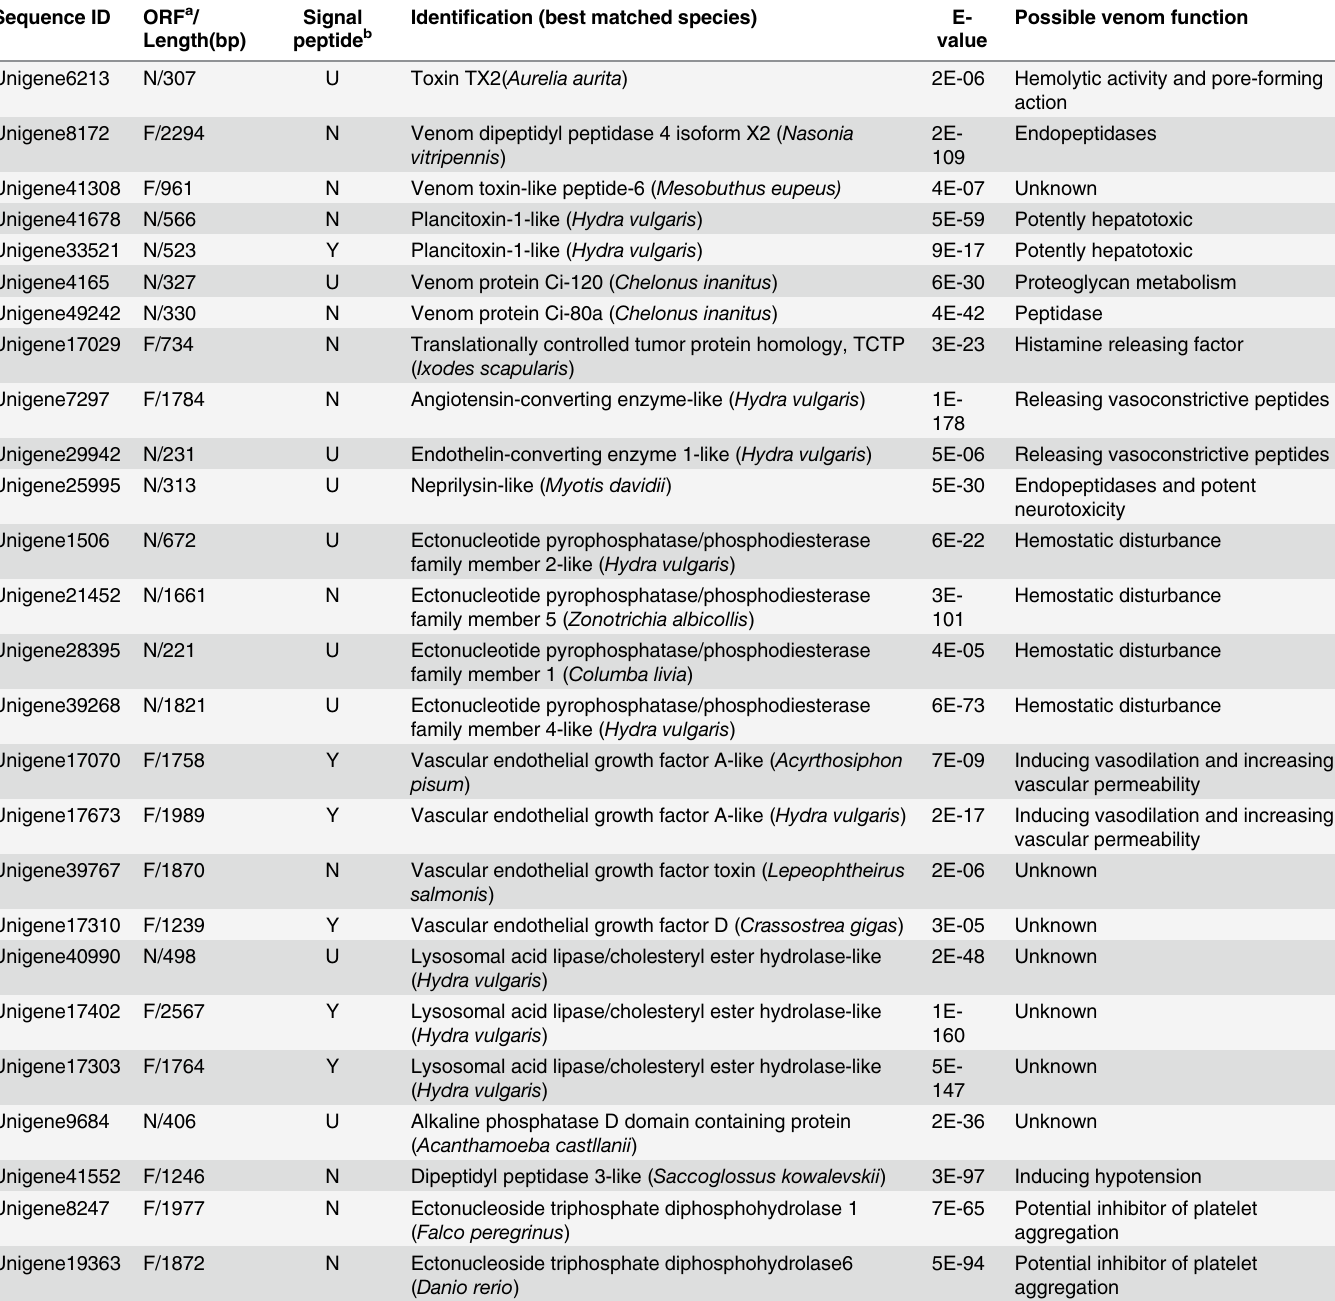
Table 3. Additional putative toxin transcripts identified by similarity searches.